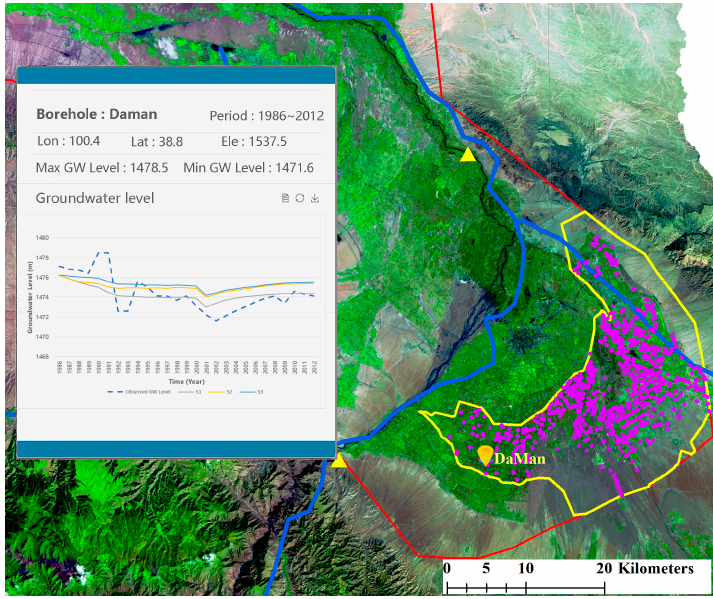
Figure 7. Real-time monitoring and management of groundwater resources.